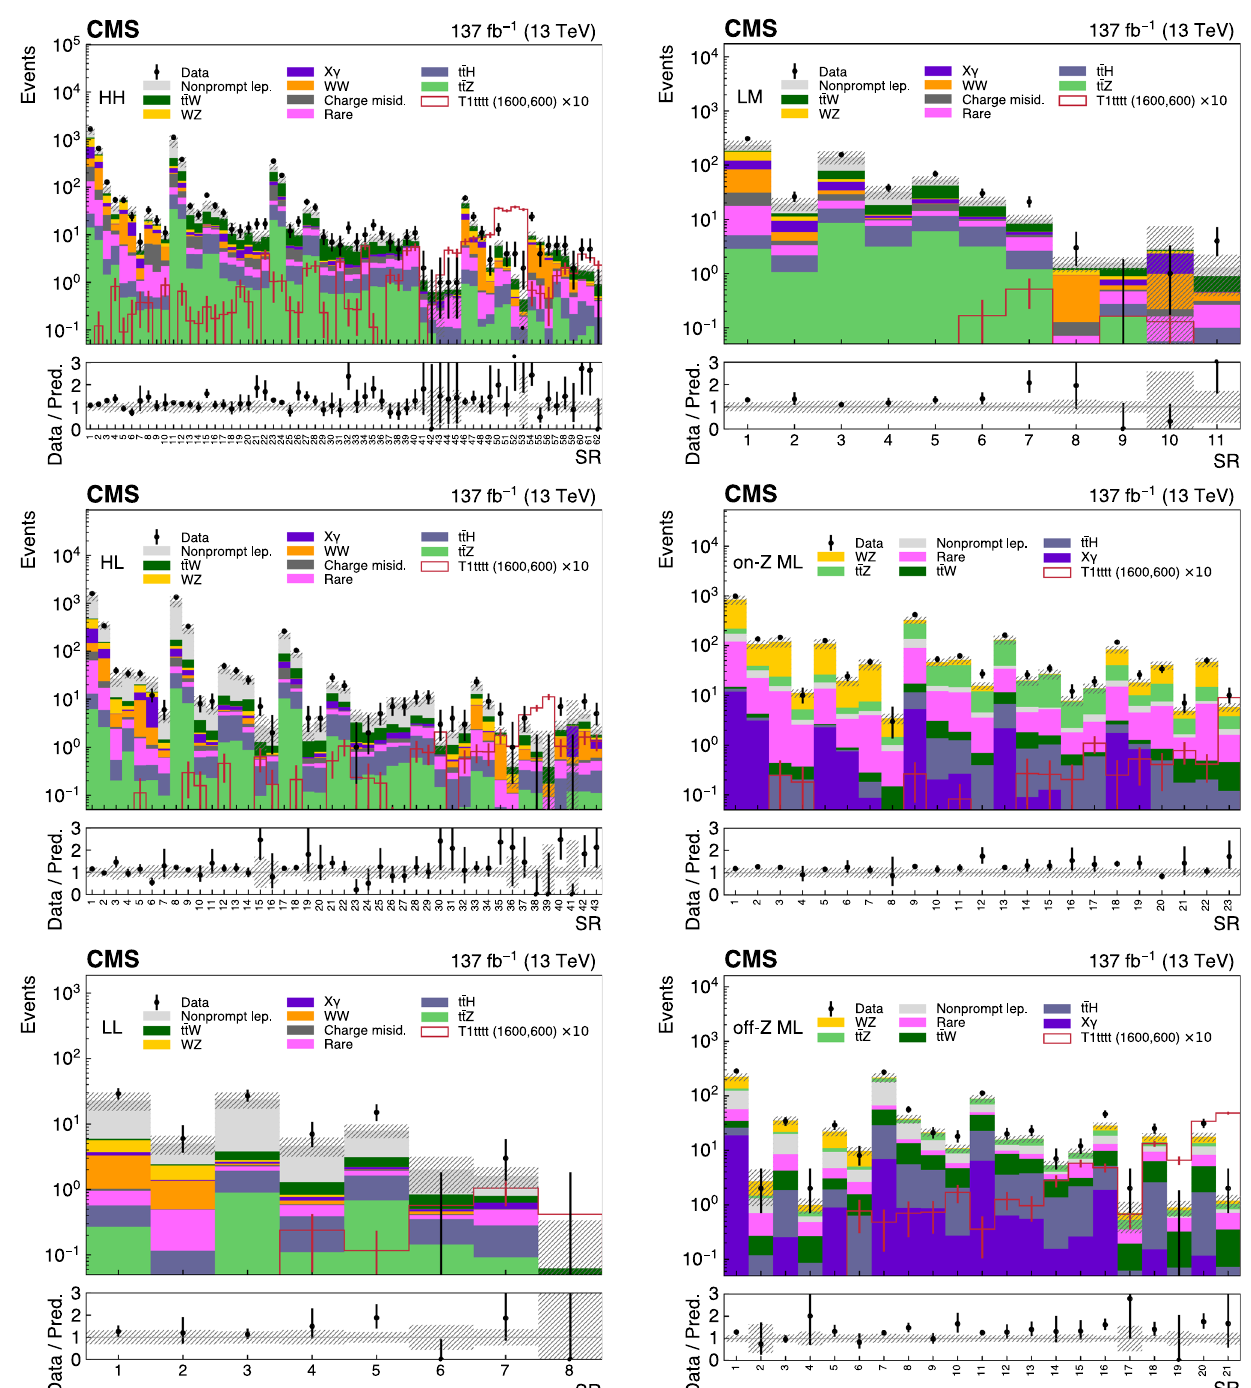
Fig. 5 ExpectedandobservedSRyieldsfortheHH,HL,LLsignalcat- egories. The hatched area represents the total statistical and systematic uncertainty in the background prediction